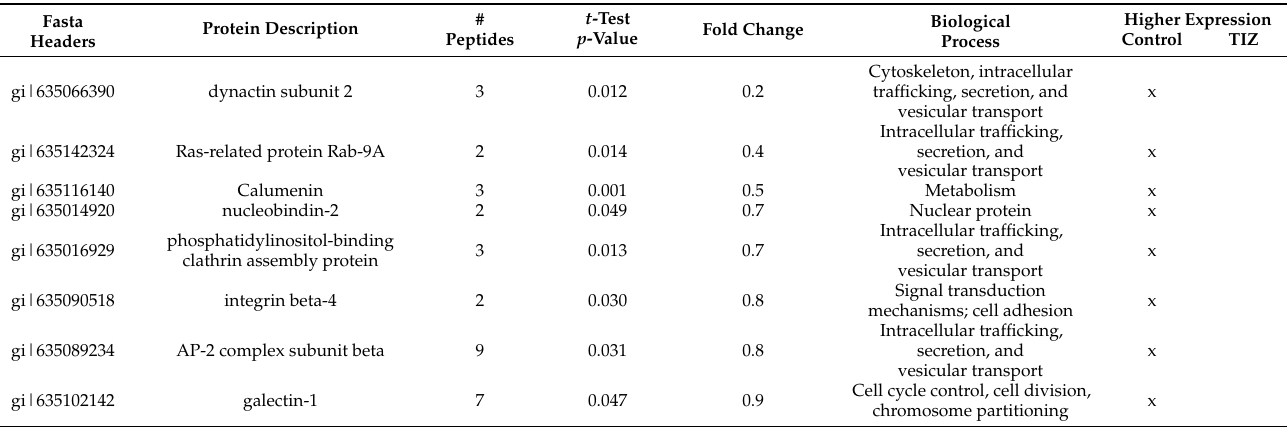
Table 3. Differential protein abundance levels in DENV-2-infected Vero cells and TIZ-treated. Samples in which the proteins presented statistically significant higher expression are marked